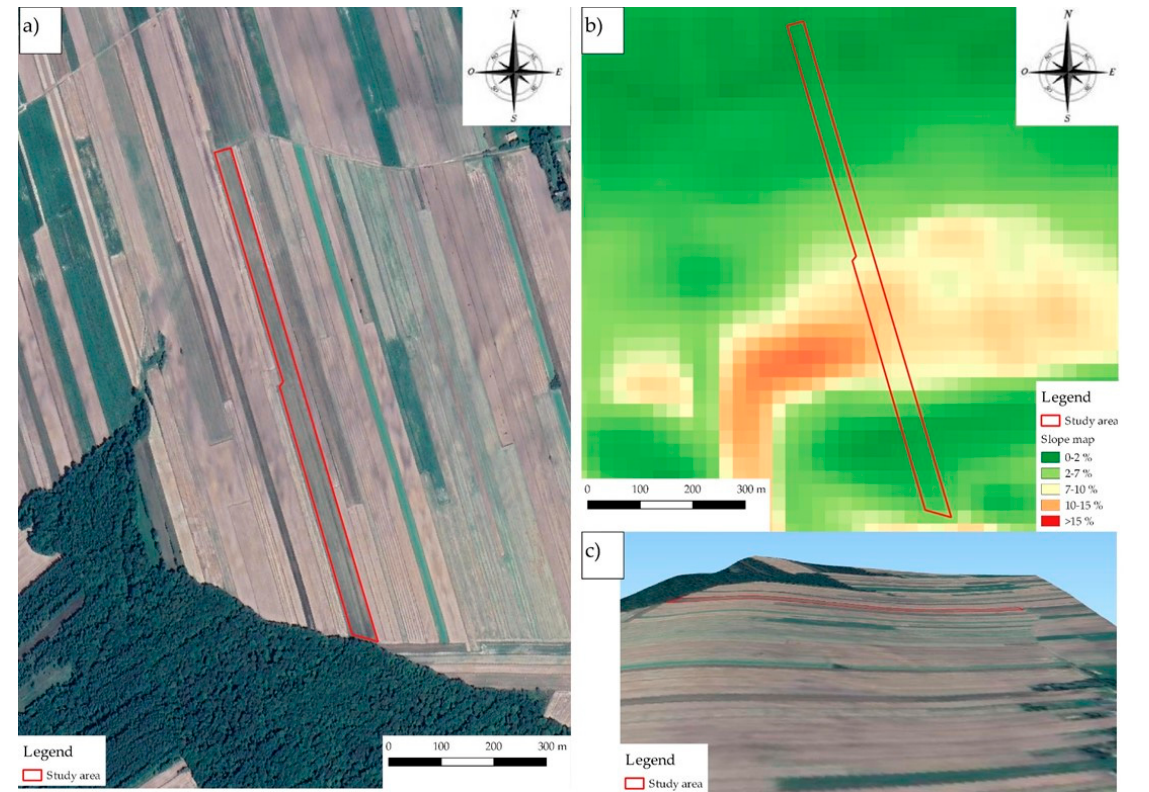
Figure 1. ( a ) Vision of the experimental field on satellite image. ( b ) Slope map of the experimental field where it is possible to identify the zones with different slope. ( c ) Three-dimensional (3D) model of the experimental field. Table 1. Characteristics of the two different zones of the experimental field.